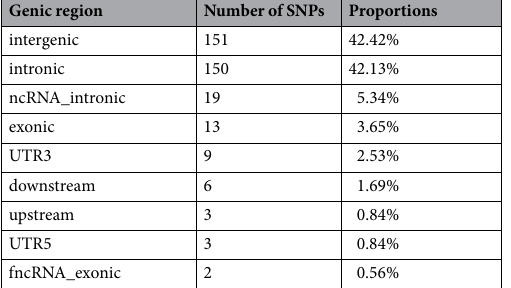
Table 1. Statistics of genetic annotations of 356 T2DM-assocated SNPs.